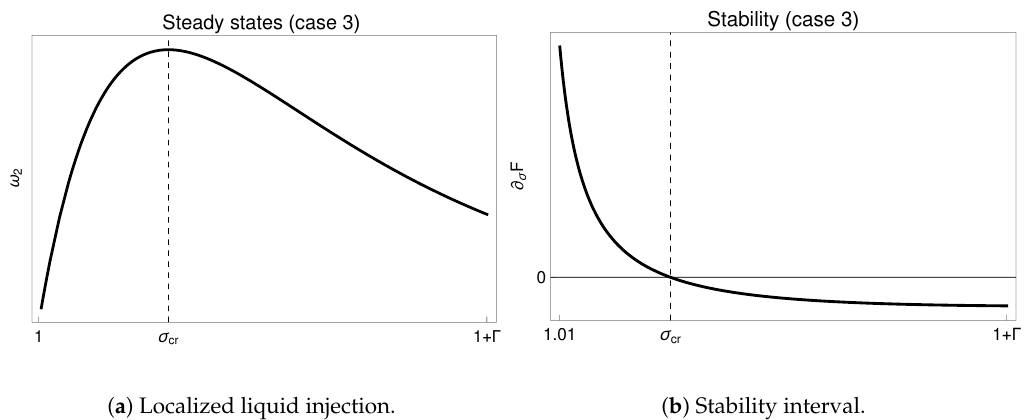
Figure 6. ( a ) Steady statein the case of a single injection well in the liquid domain. ( b ) The critical value of σ is ≈ 1.053 and ω 3,cr ≈ 3.3 × 10 − 4 . All steady states with σ ∈ ( σ cr ,1 + Γ ) and ω 3 < ω 3,cr are stable. In dimensional variables, the interface is located at − 1723 m.